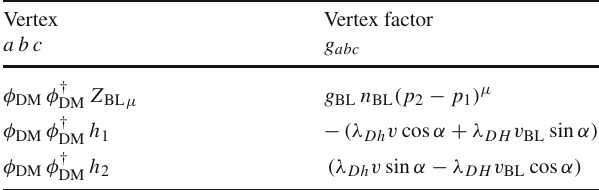
Table 3 Couplings of FIMP ( φ DM ) with Z BL , h 1 and h 2